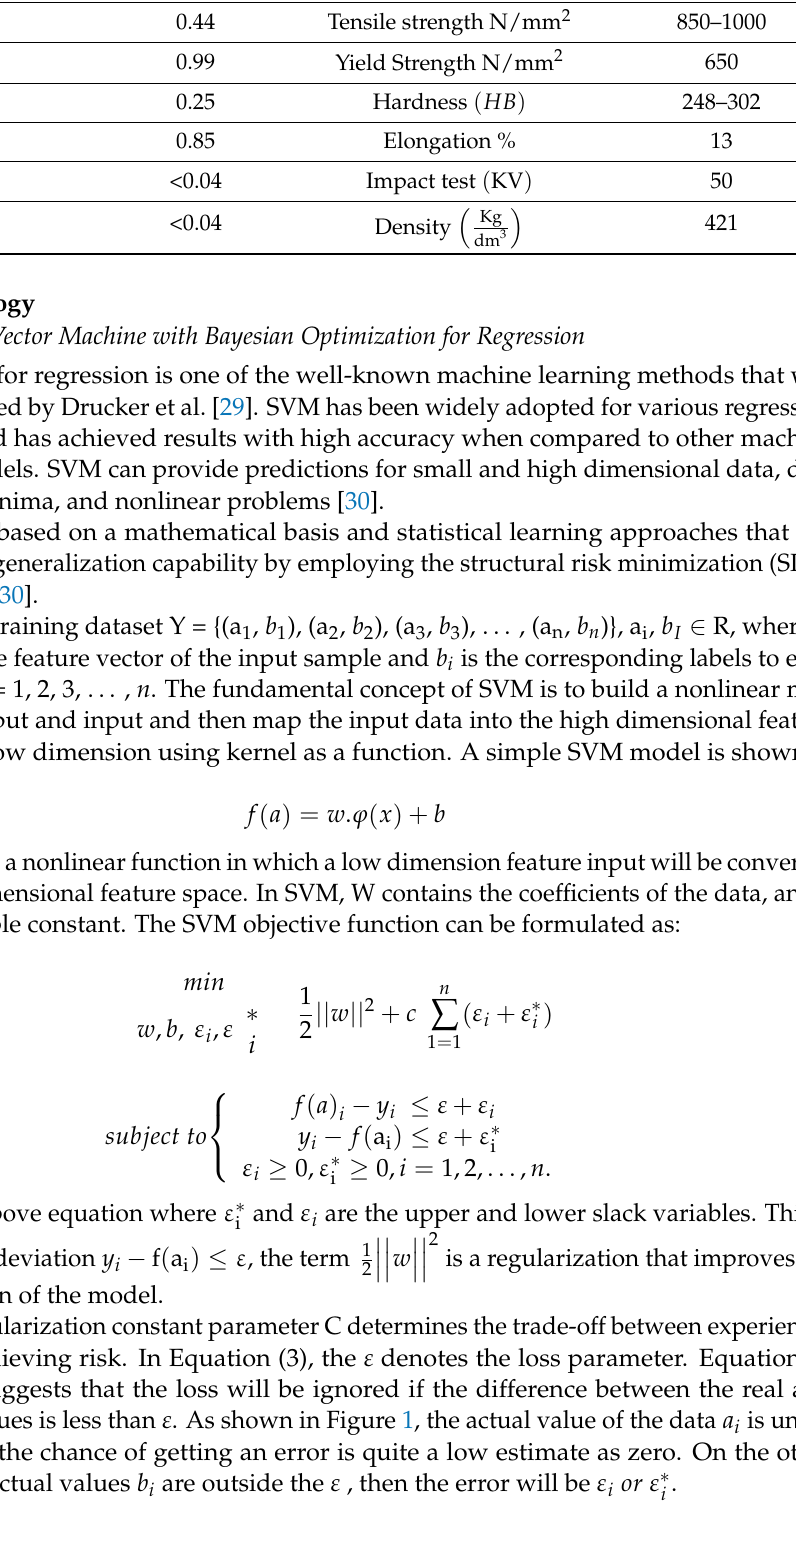
Table 1. Chemical composition, mechanical, and physical properties of the 709M40 alloy steel [27,28].